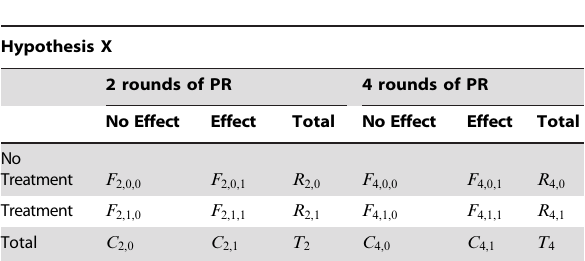
Table 1. Structure of Experimental Contingency